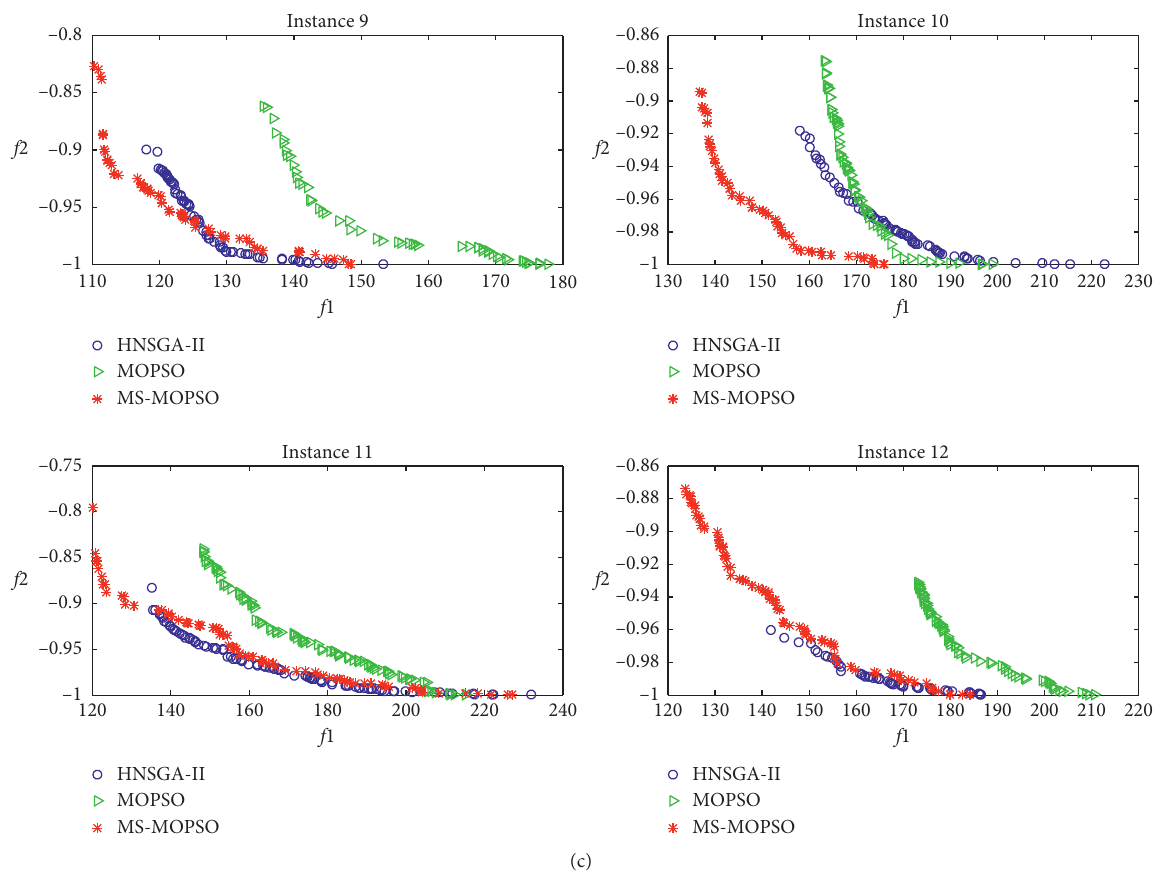
Figure 10: Pareto optimal solutions produced by MS-MOPSO, HNSGA-II, and MOPSO. (a) Small-size instances. (b) Medium-size instances. (c) Large-size